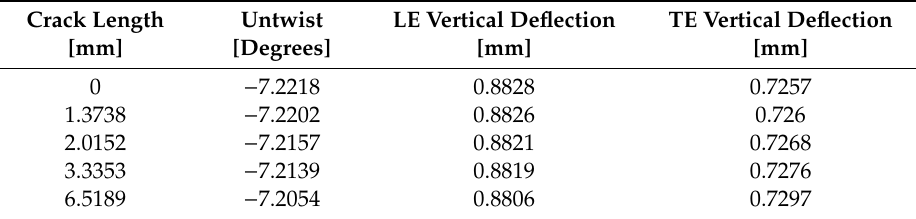
Table 6. Deformation results for the 30 ◦ short flank geometry.